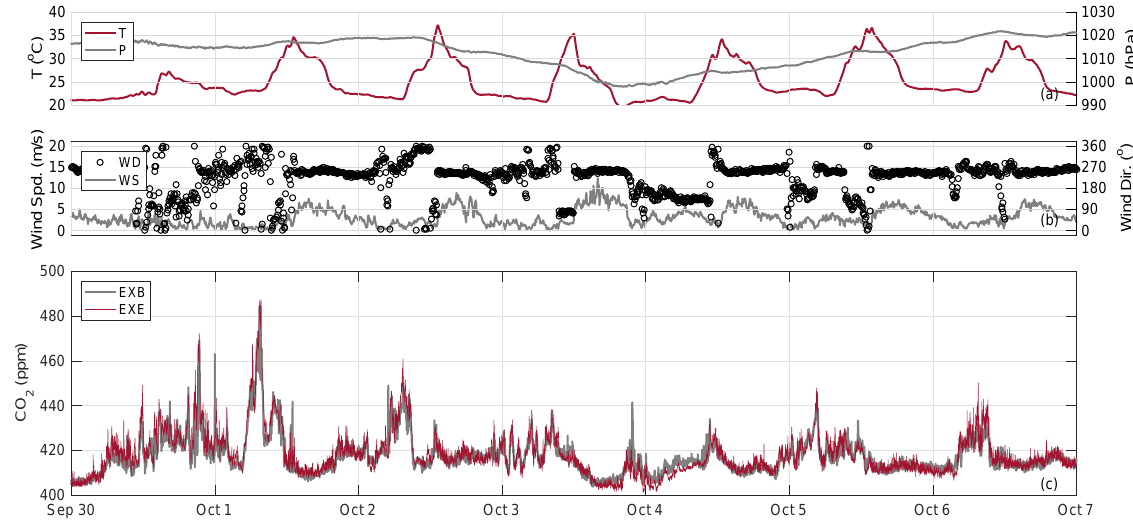
Figure 7. Representative week-long time series of observations collected at or near two nearby in-field BEACO 2 N nodes (EXB and EXE in Fig. 1; ∼ 250m apart) in October 2015: (a) temperature and pressure averaged to 1min, (b) wind speed and direction collected once every 6min, (c) drift- and bias-corrected CO 2 dry air mole fractions averaged to